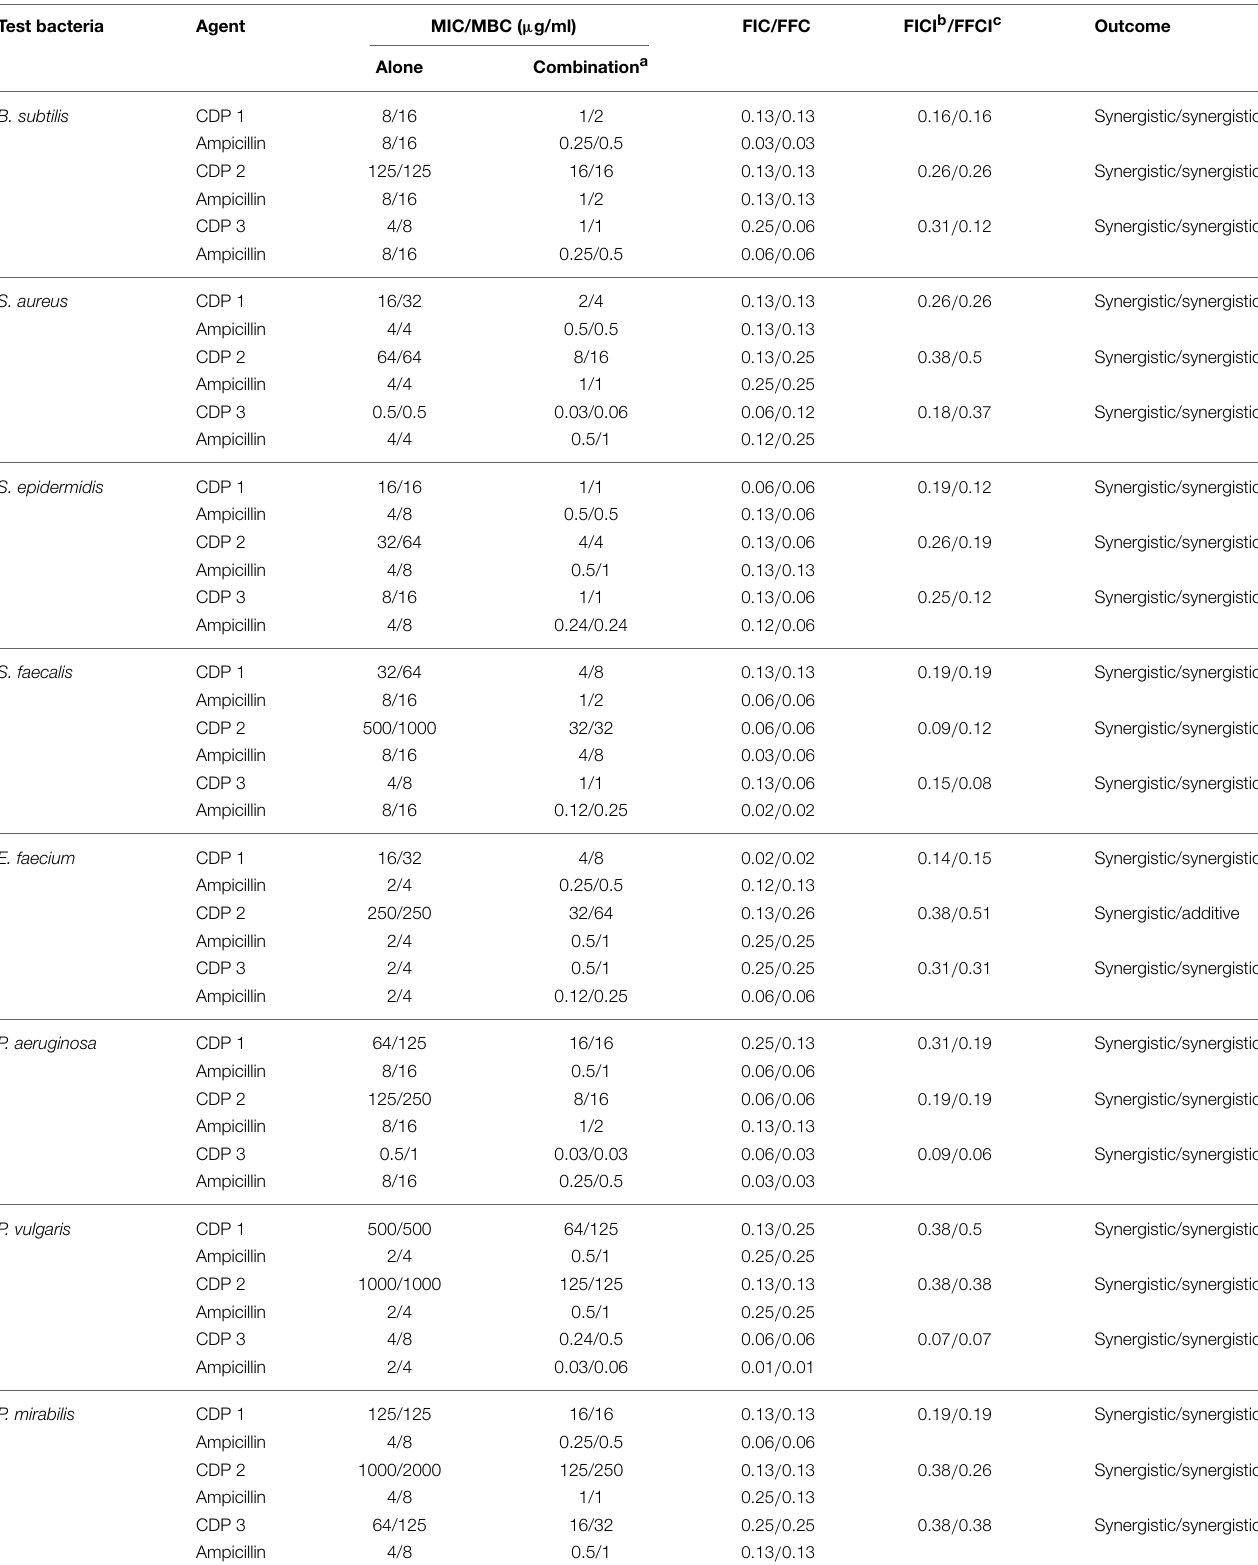
TABLE 4 | Synergistic effects of the cyclic dipeptides with ampicillin against wound associated bacteria. Test